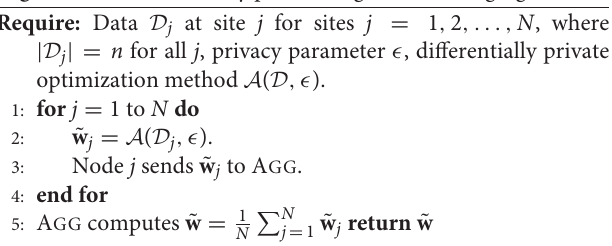
Algorithm 3 Differentially private single-shot averaging